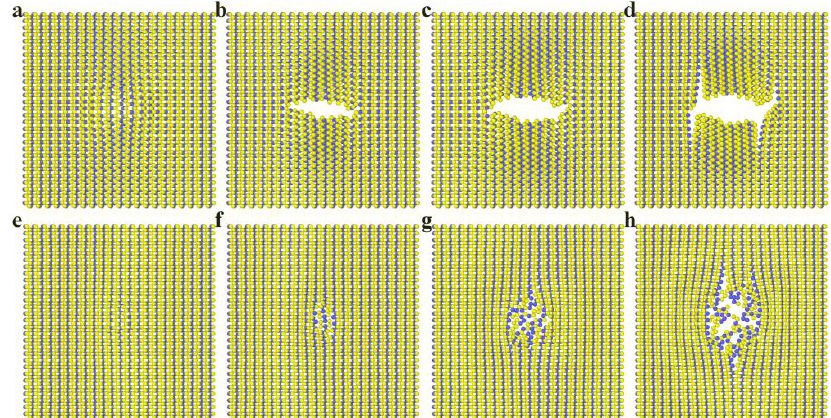
Figure 3. ( a ) The force-displacement ( F N ( d )) curve for the indentation process of Pt and BP/Pt substrate; ( b ) The force displacement curve at elastic stage (corresponding to the blue ellipse in